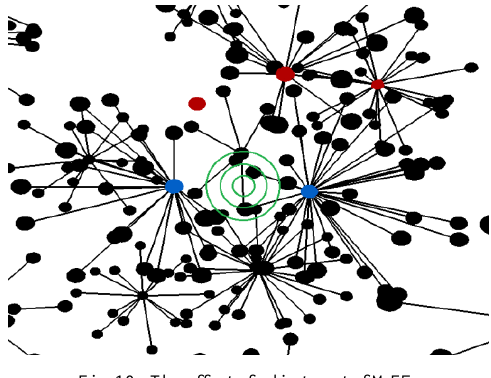
Fig. 10. The effect of adjustment of MFE.